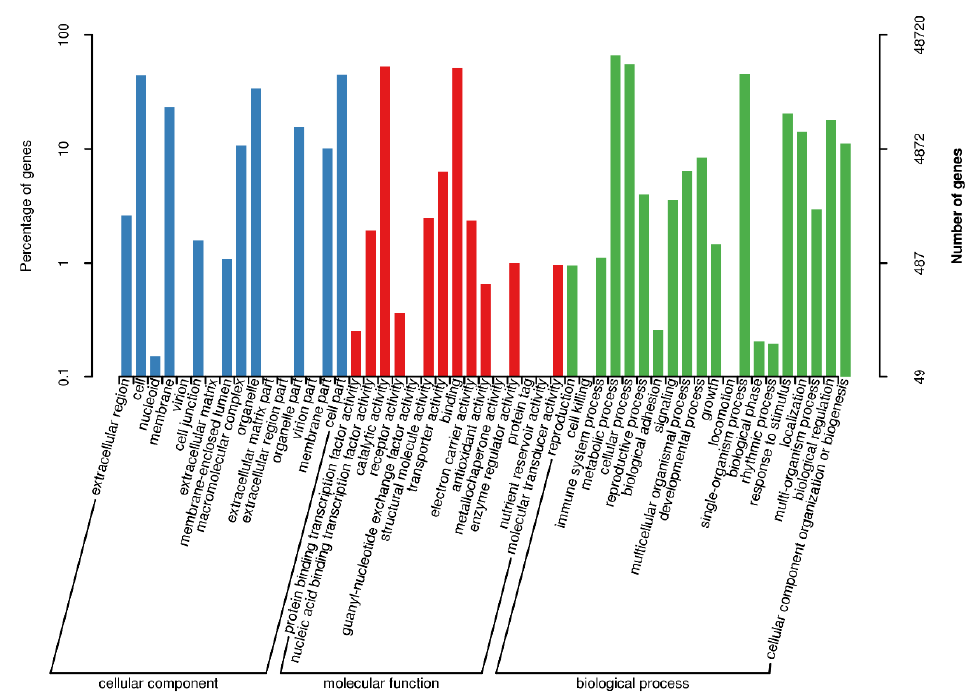
Figure A8. GO enrichment analysis of the annotated high-quality transcripts obtained by TGS. The horizontal axis represents three categories in GO, cellular component, molecular function, and biological processes. The vertical axis shows the percentage of genes that has been annotated.